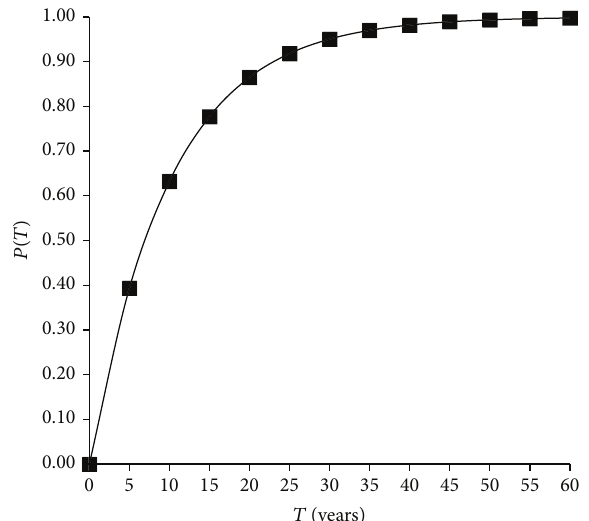
Figure1:Probabilitythataninsectoutbreakatepidemicleveloccurs within 𝑇 years, given an average time between outbreaks of 𝑎 = 10